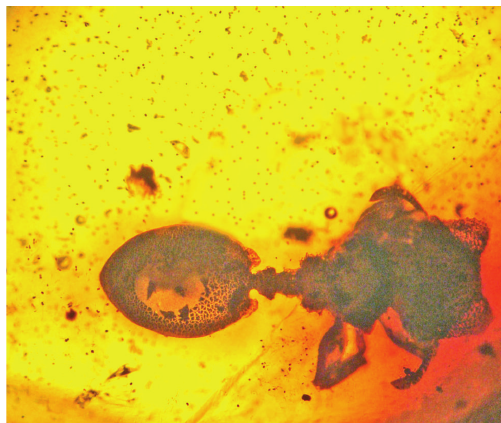
Figure 13: Worker of Cephalotes serratus infected with Myrme- conema antiqua in Dominican amber. Note microscopic eggs widely distributed in the amber that were released from a hole in the ant’s gaster.